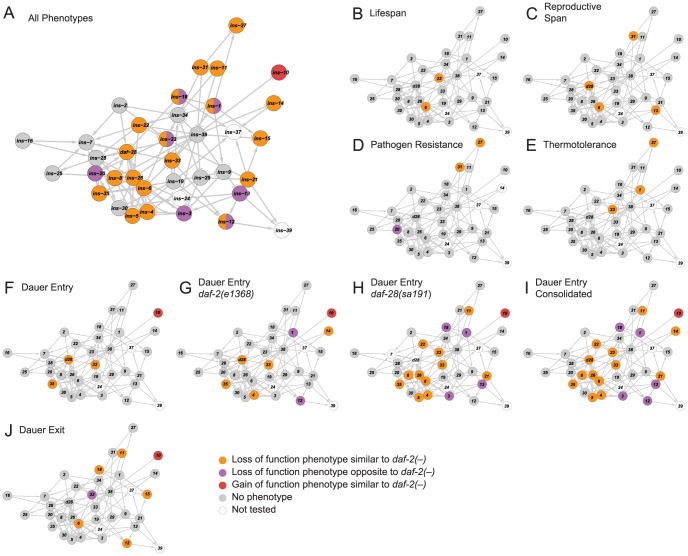
Functional maps of the ILP network.Phenotypes of the ILPs were mapped onto a spring-embedded layout of the ILP network; directions of phenotypes are indicated in the legend (bottom right). (A) shows the network where ILPs with phenotypes are highlighted based on their phenotypic direction compared to daf-2 mutants. ILPs with both similar and opposite phenotypes to daf-2 are indicated with a split circle. (B–J) shows the network highlighted for phenotypes as indicated.